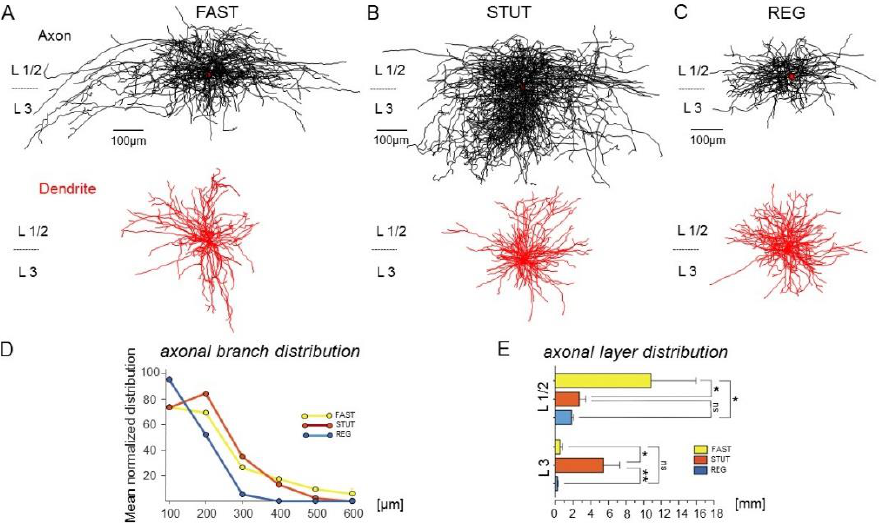
Figure 2. Morphological features of FAST, STUT, and REG. ( A – C ) Superimposed Neurolucida reconstruction of 9 cells each for FAST ( A ), STUT ( B ), and REG ( C ). While the dendrite morphology (in red) in all IN types was broadly similar, the axons (in black) of FAST and REG formed typical arbors, restricted mainly within the L1-2, whereas the STUT cells axon also has a prominent axonal arborization in L3. Therefore, STUT cells exhibited extensively arborized, long-ranging axons distributed at a larger distance in L2-3, both horizontally and vertically. Soma is depicted within the axonal reconstruction in red. ( D ) Mean normalized distribution of axonal branches evaluated by Sholl analysis using six concentric nested spherical shells (each 100 μ m) in successive radial distance from the soma. ( E ) Summary bar charts showing the axonal layer-specific distribution of FAST (yellow bars), STUT (orange bars), and REG (blue bars). p values are given as ns ( p > 0.05), * ( p ≤ 0.05 ) and ** ( p ≤ 0.01 ).